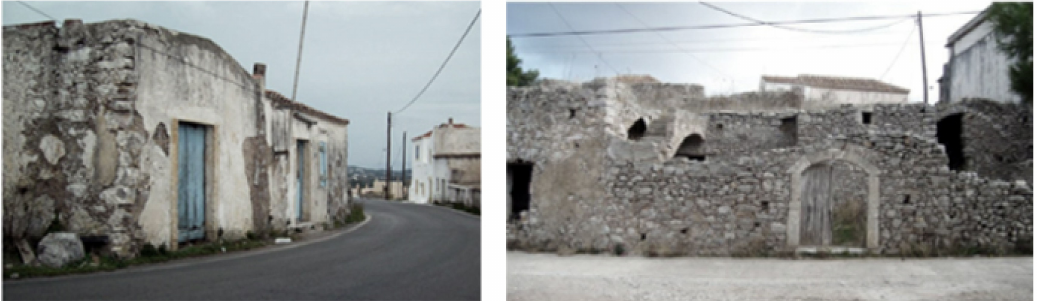
Figure 21. Aroniadika in